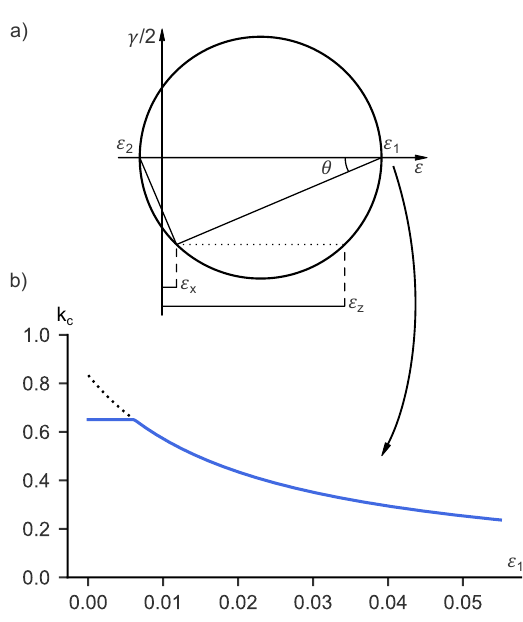
Figure 3. Core components of the optimisation prob- lem: a) Mohr’s circle of strains in pure shear b)